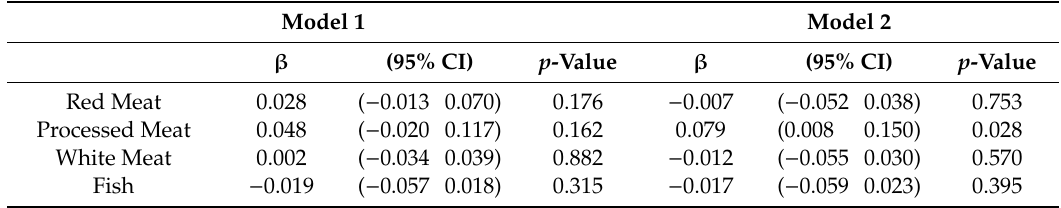
Table 3. Quantile regression models with Liver Iron Content as the dependent variable and dietetic factors as independent